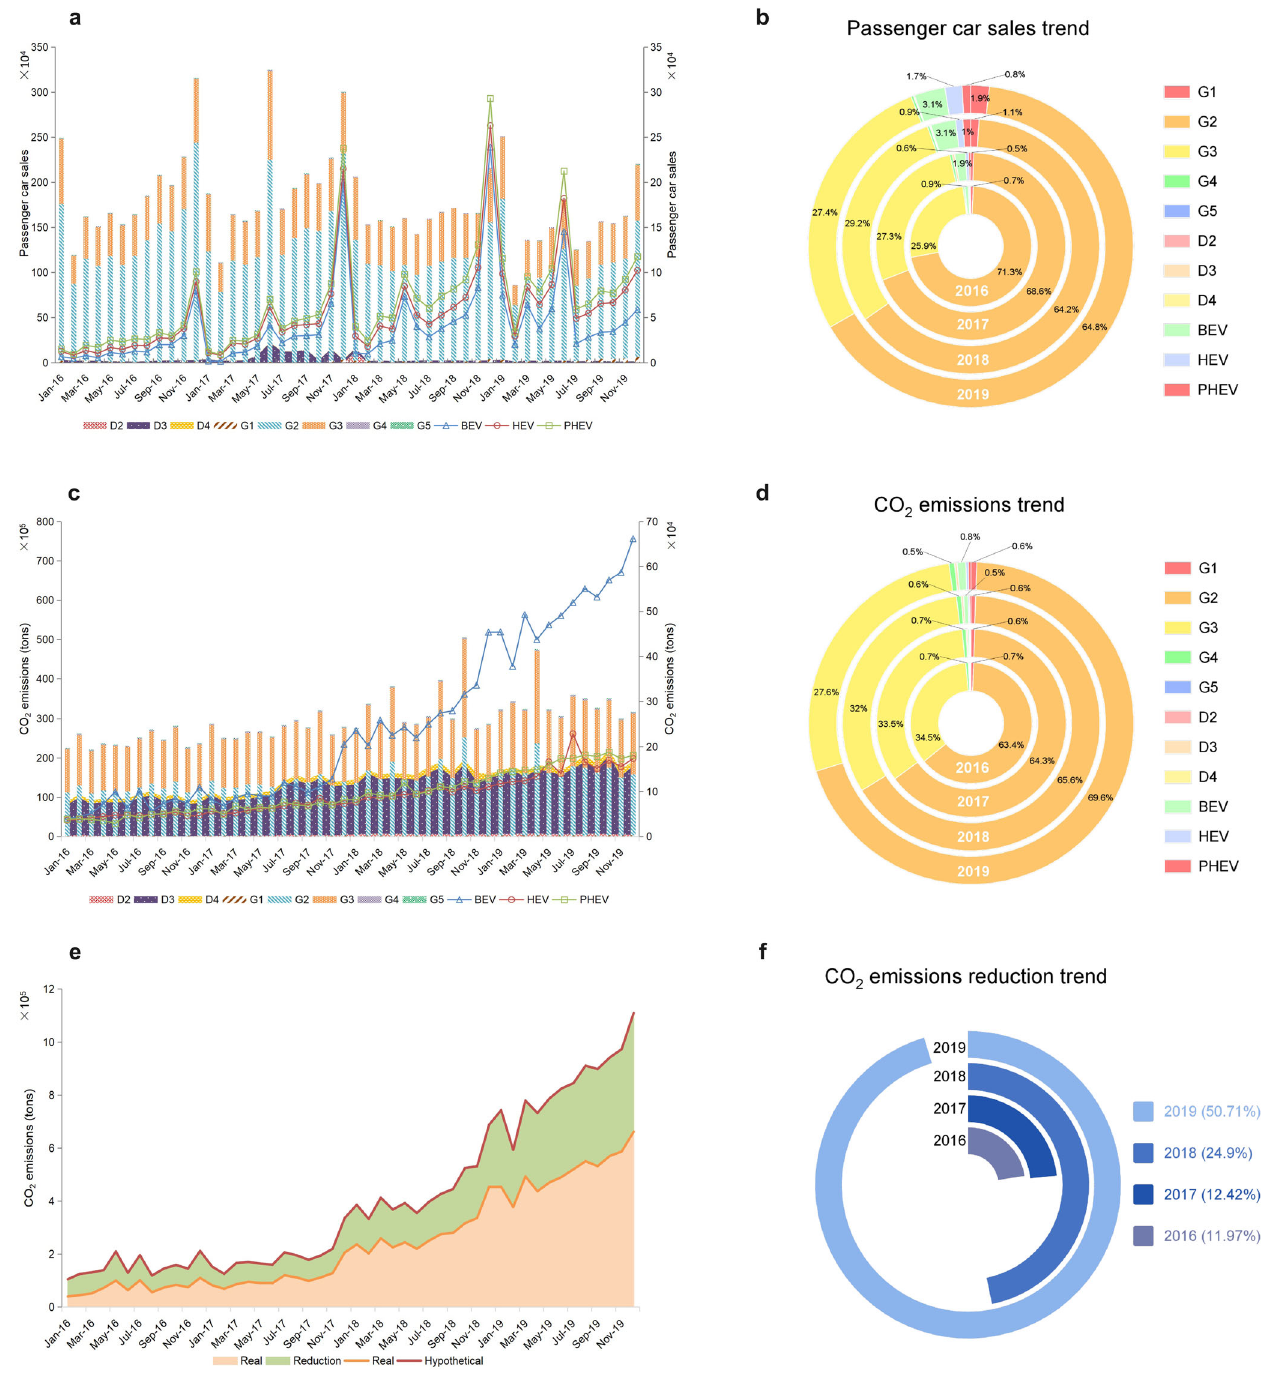
Fig. 3 Month-to-month sales, CO 2 emissions, and carbon reduction due to vehicle electri fi cation for China ’ s road passenger transport. a Passenger car sales; b passenger car sales trend; c road passenger transport CO 2 emissions; d road passenger transport CO 2 emissions trend; e carbon reduction due to vehicle electri fi cation; f trend of carbon reduction due to vehicle electri fi cation (G1 = Gasline Mini Car; G2 = Gasoline Common Class Car; G3 = Gasoline Middle Cass Car; G4 = Gasoline Middle-High Class Car; G5 = Gasoline High Class Car; D2 = Diesel Common Class Car; D3 = Diesel Middle Cass Car; D4 = Diesel Middle-High Class Car; Hybrid Electric Vehicle = HEV; Plug-in Hybrid Electric Vehicle = PHEV; Real = electricity from thermal power; Reduction = real carbon reduction due to vehicle electri fi cation; Hypothetical = electricity from clean energy). Source data are provided in Source Data fi